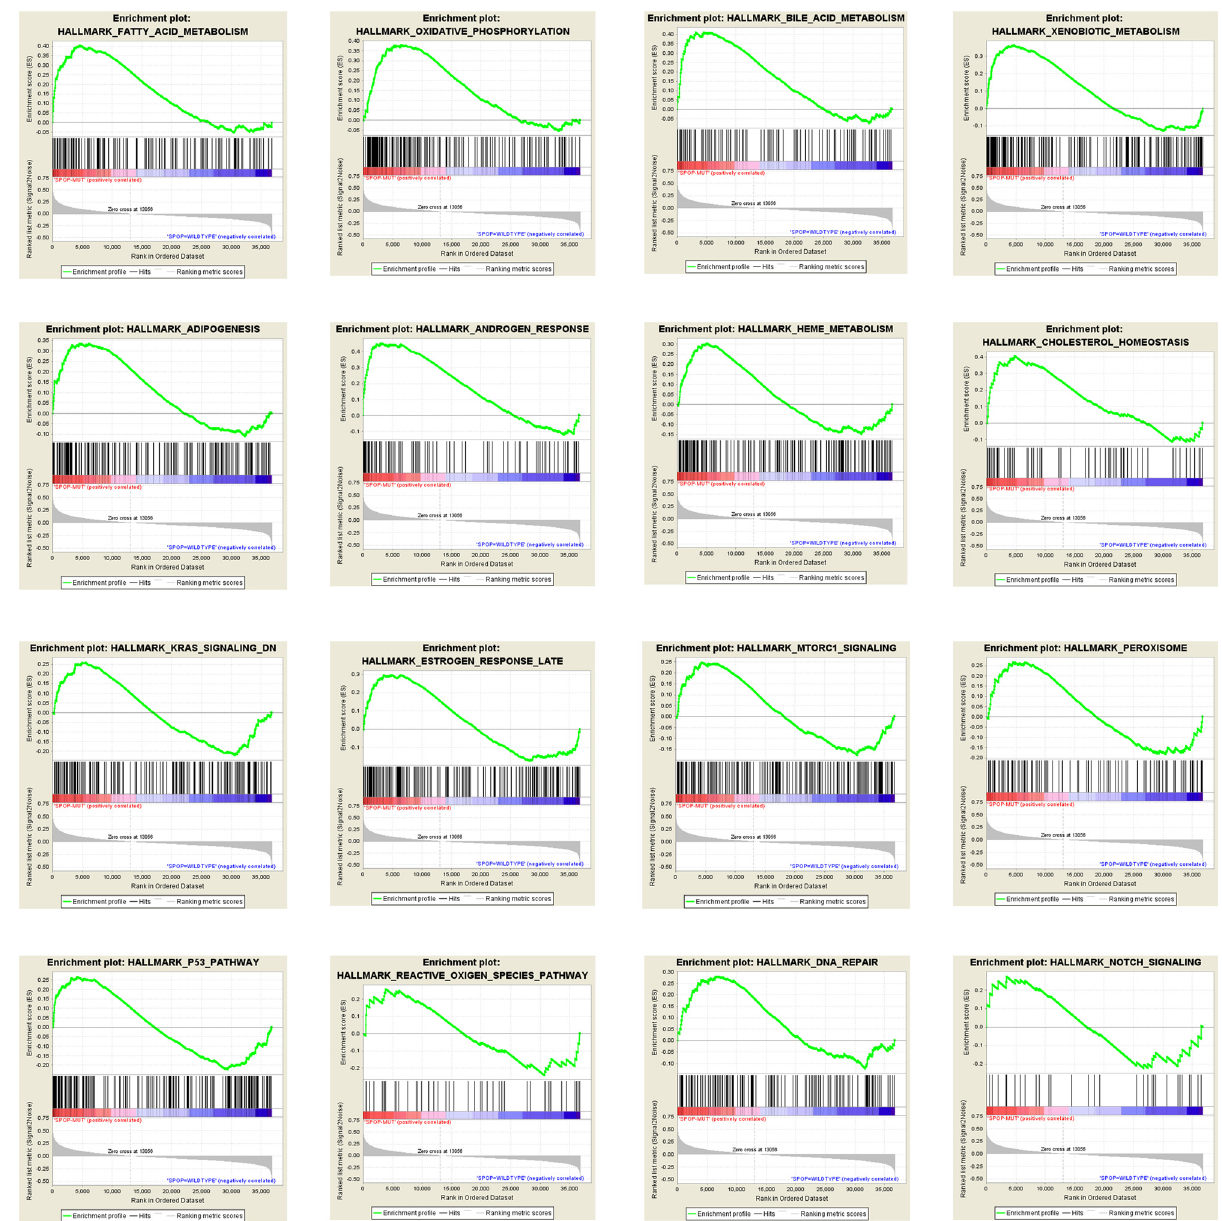
Figure 2: GSEA results of SPOP mutation in patients with